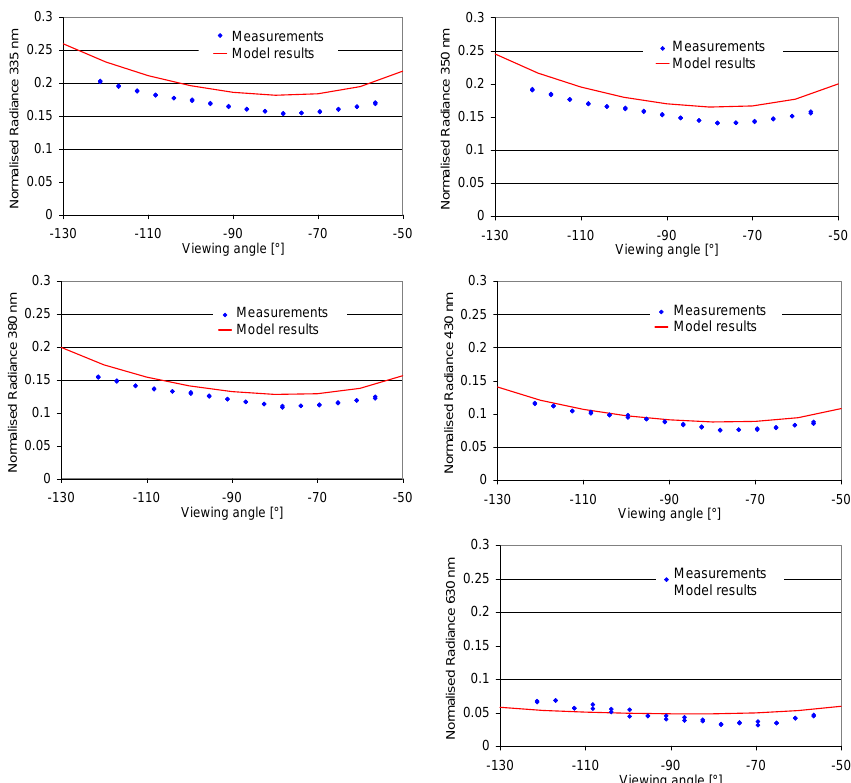
Fig. 9 Observed (blue dots) and modelled dependency of the normalised radiance on the viewing angle for selected cloud-free observations (results of two consecutive SCIA scans) over Eastern Europe (17 September 2006, see Fig. 7). For the radiative transfer calculations the following parameters were assumed: surface albedo: 3%, the aerosol layer: 0–1km; aerosol SSA: 0.95; g : 0.68, AOD: 0.05 (630nm) and 0.1 (all other wavelengths). A viewing angle of −90° indicates nadir viewing geometry.